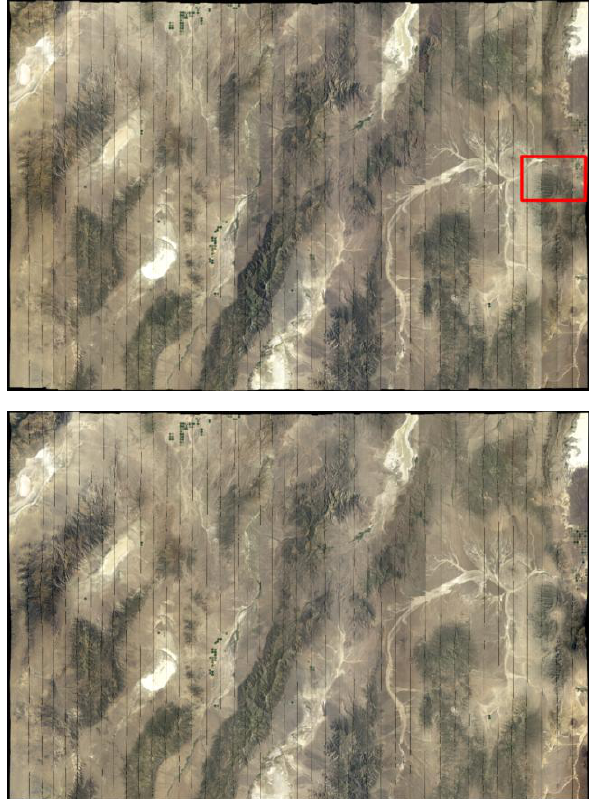
Figure 9. ADS100 ortho-image mosaic in Nevada. Top: image strips after atmospheric and BRDF correction; bottom: result of the radiometric normalization. The rectangle marks the area of Figure 10. Level